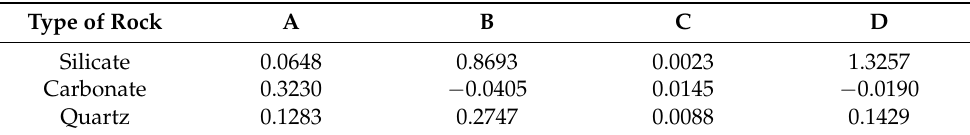
Table 10. Parameters of Equations (22) and (23) for the in situ fracture toughness value K I,ins [59].